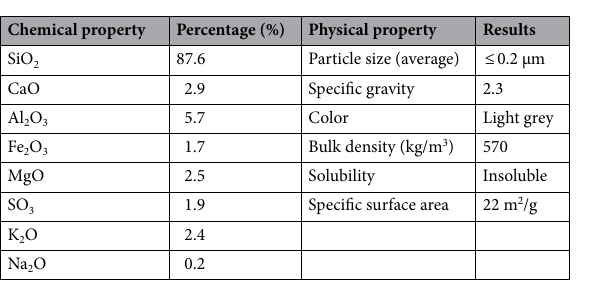
Table 4. Chemical and physical properties of silica fume.